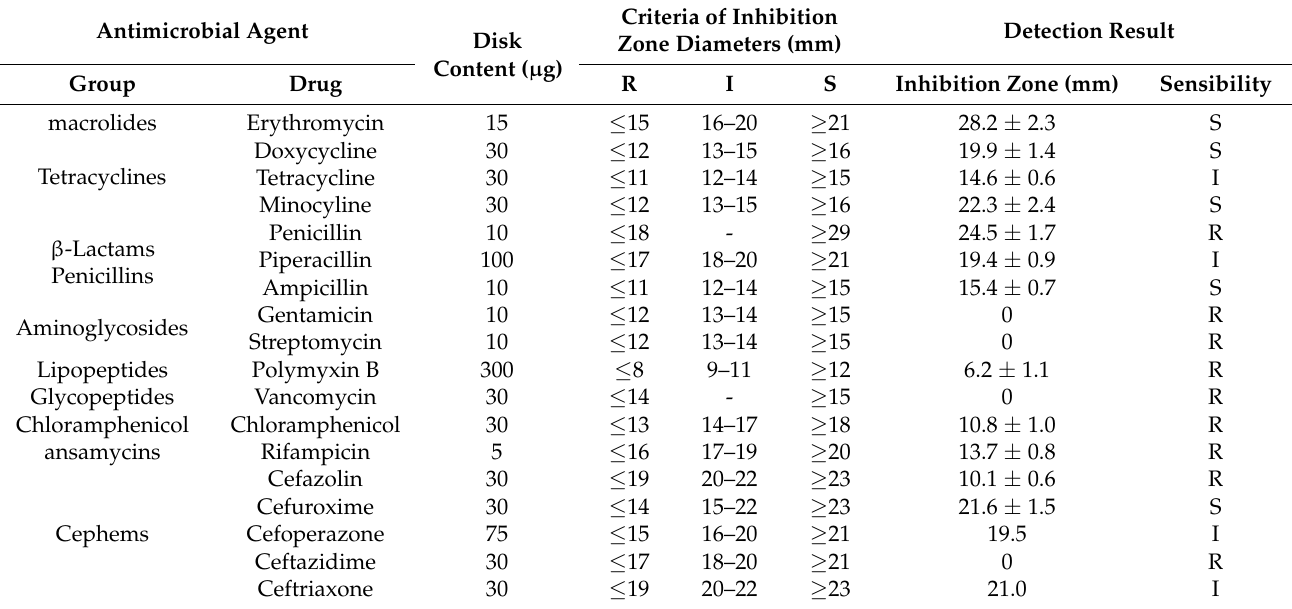
Table 2. Antibiotic sensitivity of L. mesenteroides